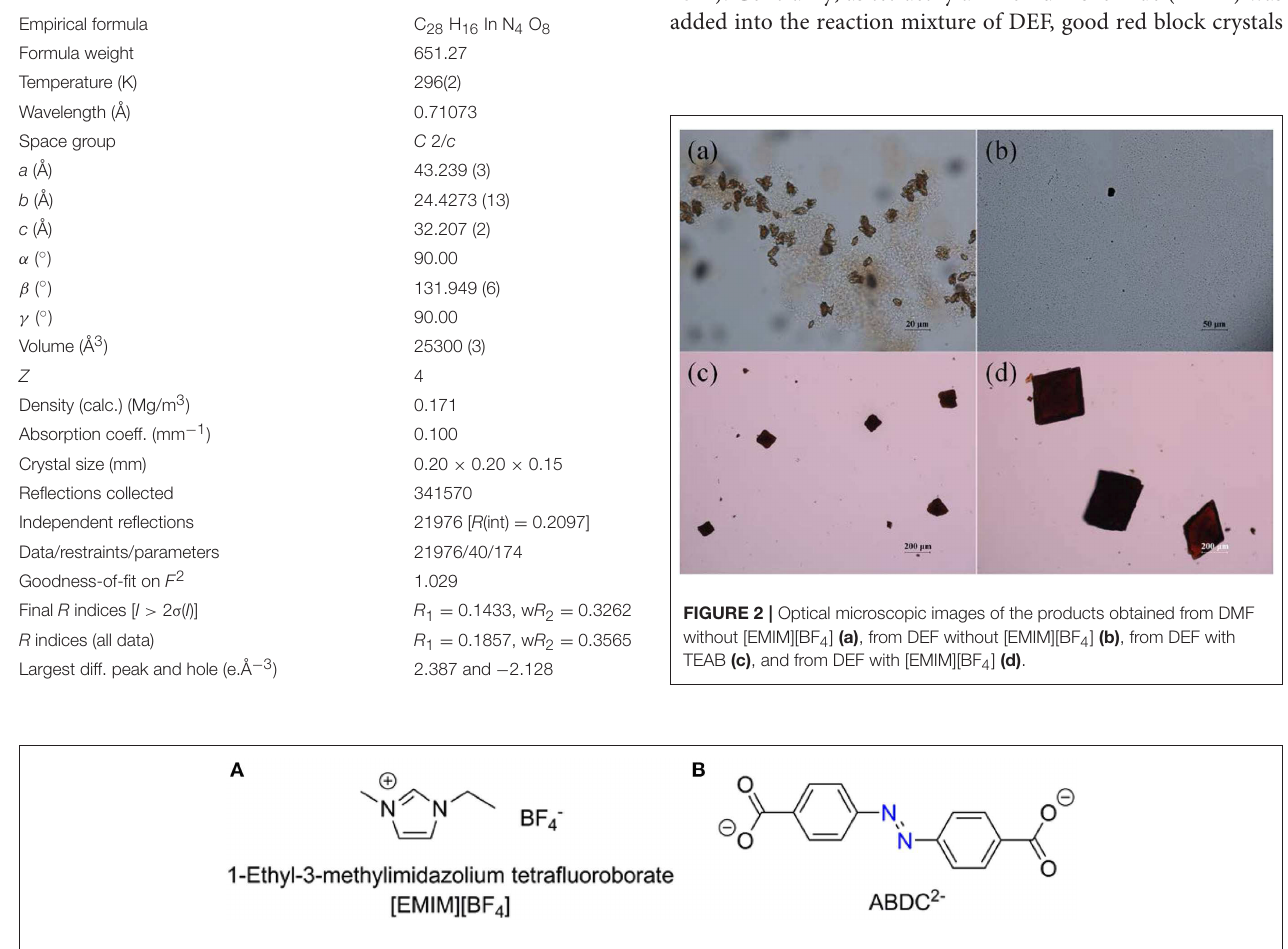
FIGURE 1 | The chemical structures of [EMIM][BF 4 ] (A) and ABDC 2 − bridging ligand (B) .